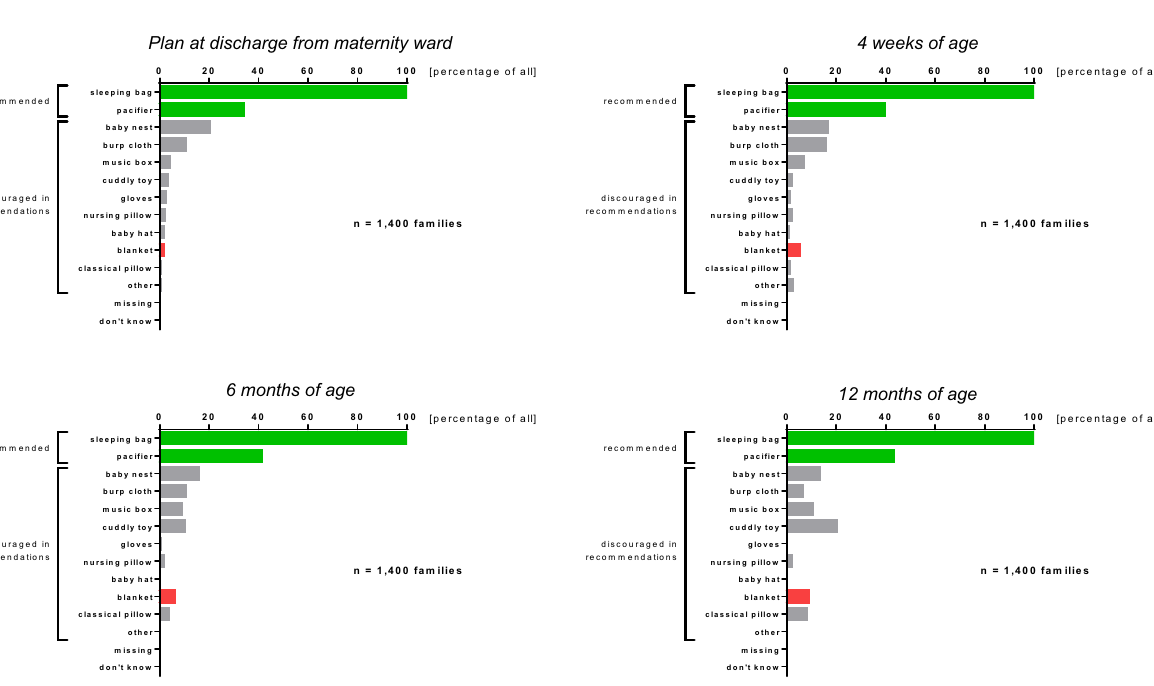
Figure 5. Loose objects in the infant’s bed ( “Which of the following objects do you give the infant into the bed for sleeping?”